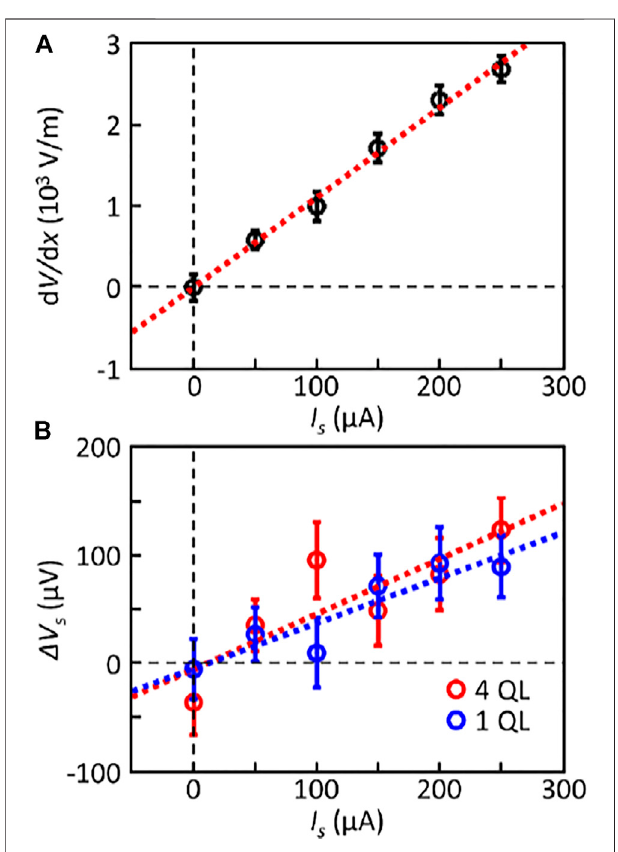
FIGURE 4 | (A) Current dependence of the potential slope extracted from the line pro fi les in Figure 3F (B) Current dependence of the potential change across the step edges extracted from the line pro fi les in Figure 3G